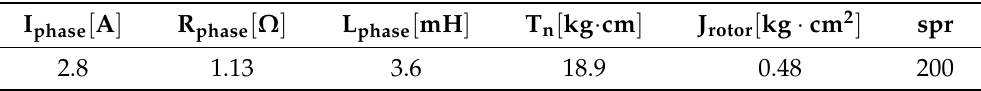
Table 3. Nominal parameters of the SM57HT76-2804B bipolar stepper motor. “spr” means “steps per revolution”.